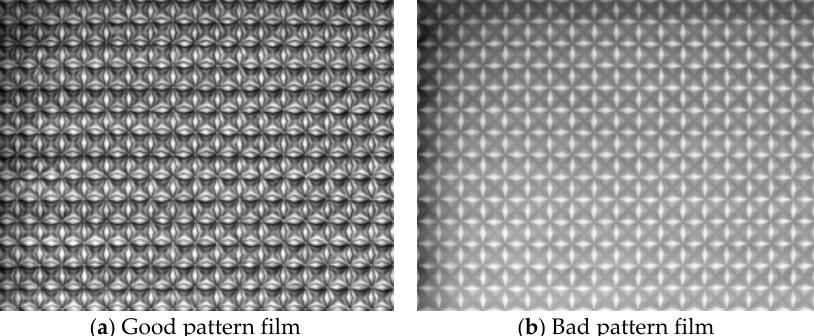
Figure 1. Two types of 3D pattern film